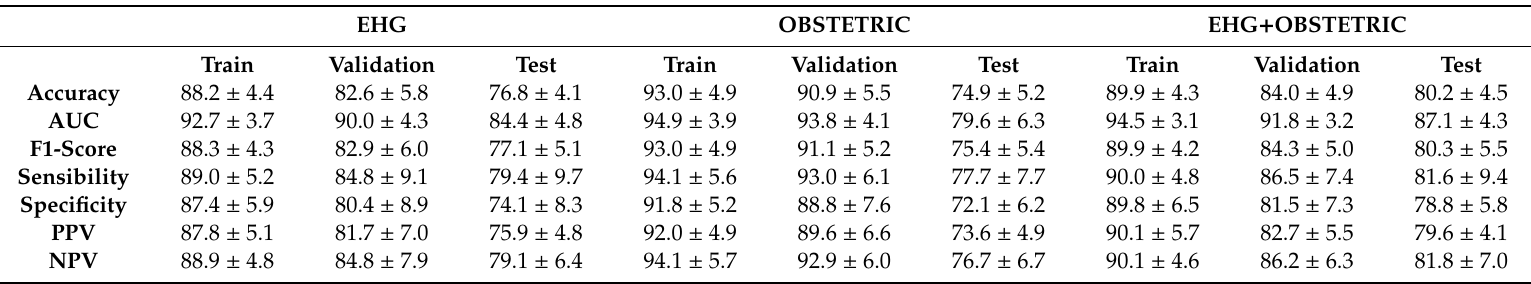
Table 4. Mean and SD of model performance indicators in predicting labor in under or over 7 days using EHG characteristics, obstetric data or a combination of both.